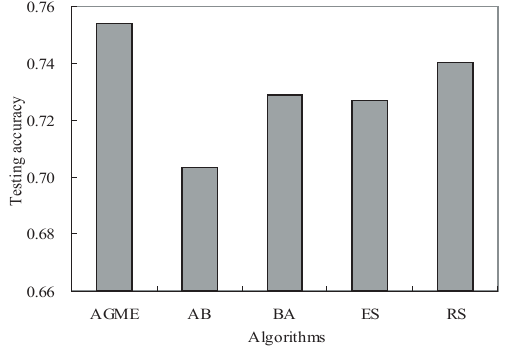
Fig.1. The average testing accuracy of the five algorithms The experimental results indicate that the AGEM achieves the best performance among the five ensemble algorithms. Moreover, about half of the features are removed by the AGEM, which means the proposed algorithm can filter the irrelevant ratings and obtain higher classification accuracy with a more compact rating